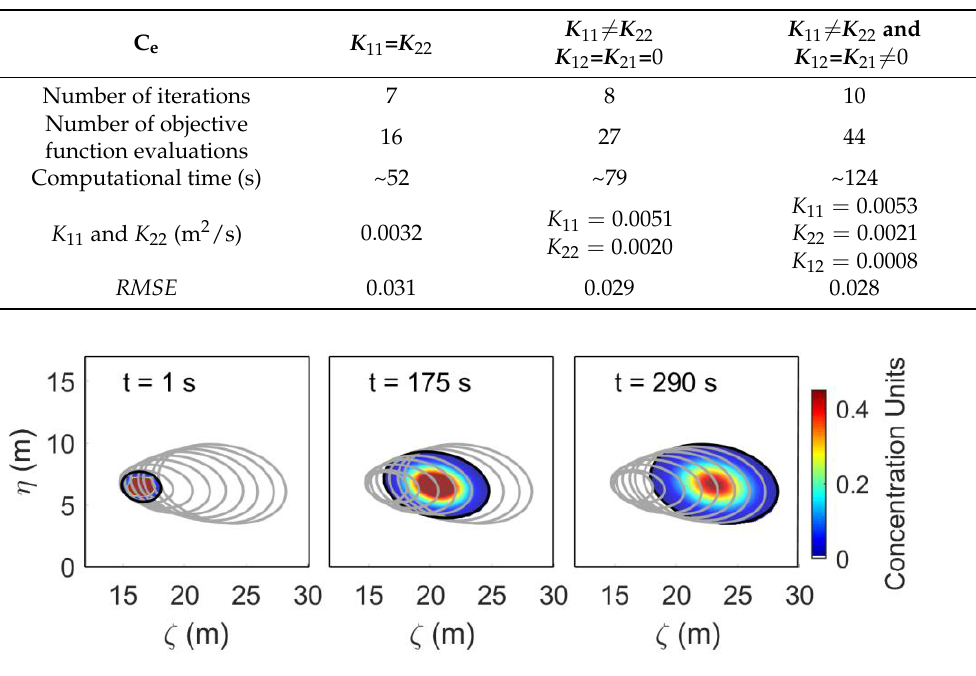
Figure 7. Concentration distribution. Concentration contours obtained with the optimal diffusion coefficient 𝐾 11 ≠ 𝐾 22 and 𝐾 12 = 𝐾 21 = 0 . The gray contour exemplifies the temporal evolution.